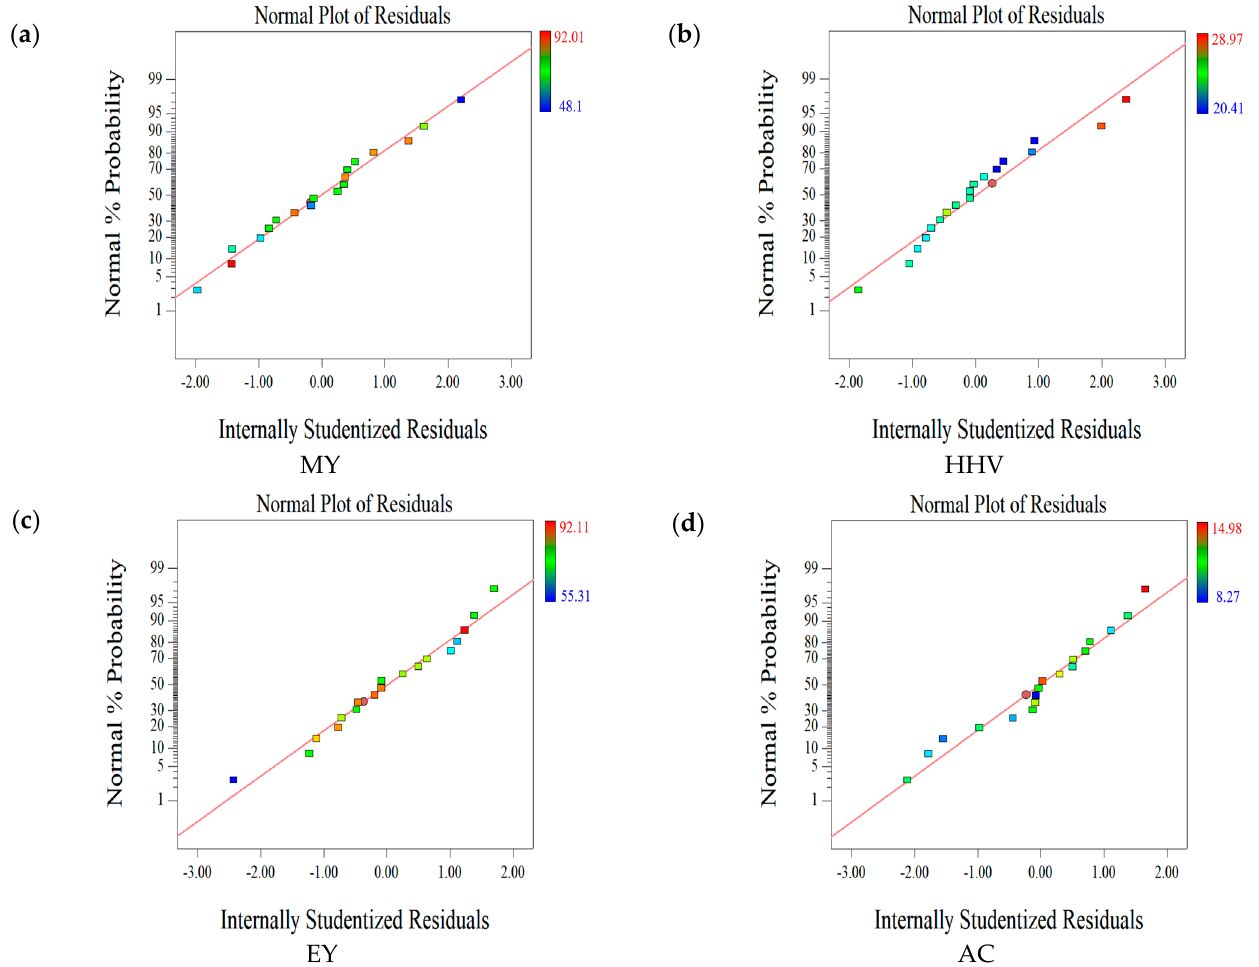
Figure 1. Residual analysis of ( a ) mass yield (MY), ( b ) higher heat value (HHV), ( c ) energy yield (EY), and ( d ) ash content (AC).